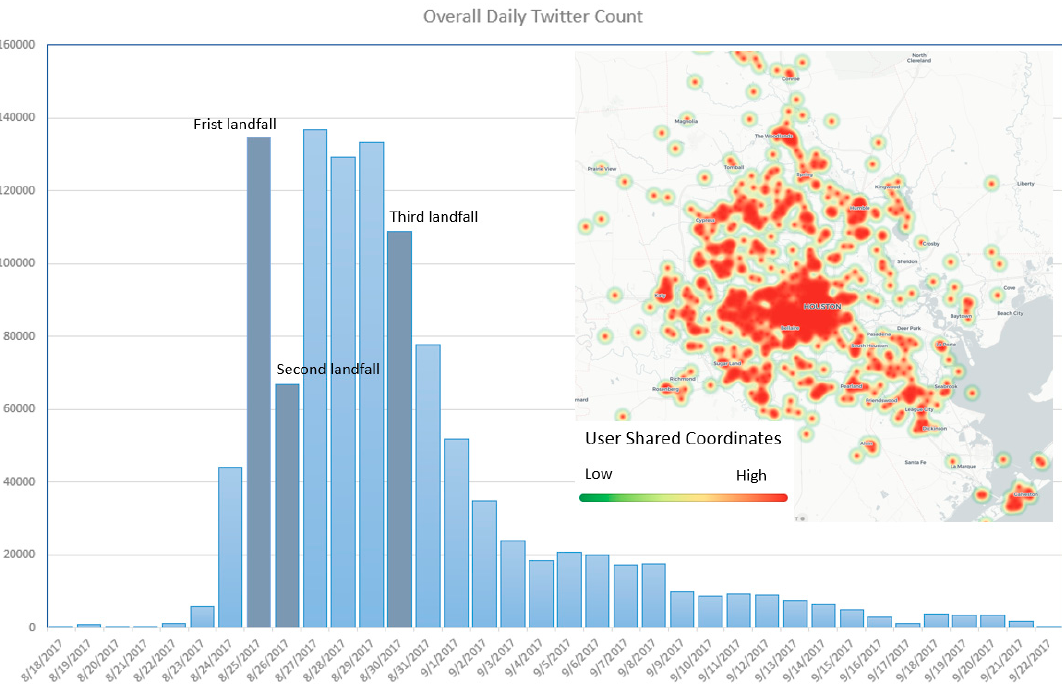
Figure 4. Spatiotemporal distribution of original data. The map (center in the Houston area) shows geographic distribution within all user shared coordinates, and the bar chart demonstrates a temporal distribution. Three landfalls are marked in dark blue color on August 25, August 26, and August 30.